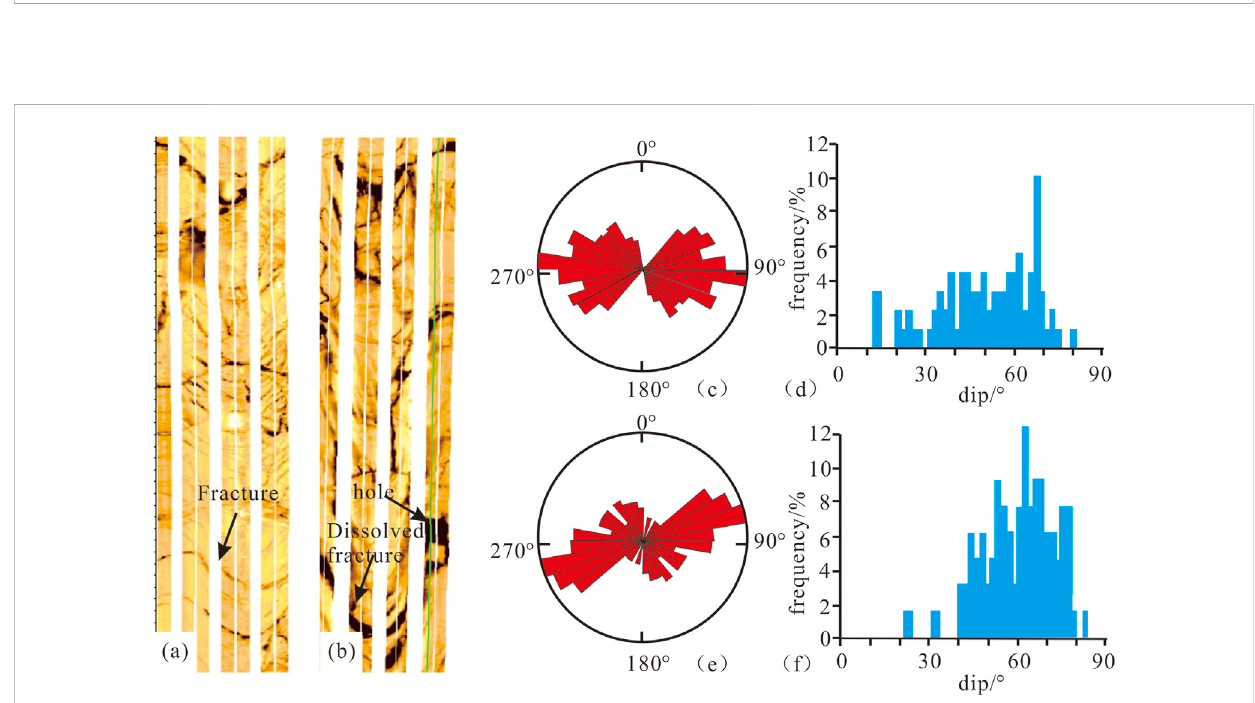
FIGURE 4 FracturedevelopmentinCarbonateburiedhillreservoirsintheCFD2area.[ (A) :Imagingloggingresponseofstructuralfractures; (B) Imaginglogging response of dissolved fractures; (C,D) Trend and dip angle of structural fractures in Well CFD2-B; (E,F) Trend and dip angle of structural fractures in Well